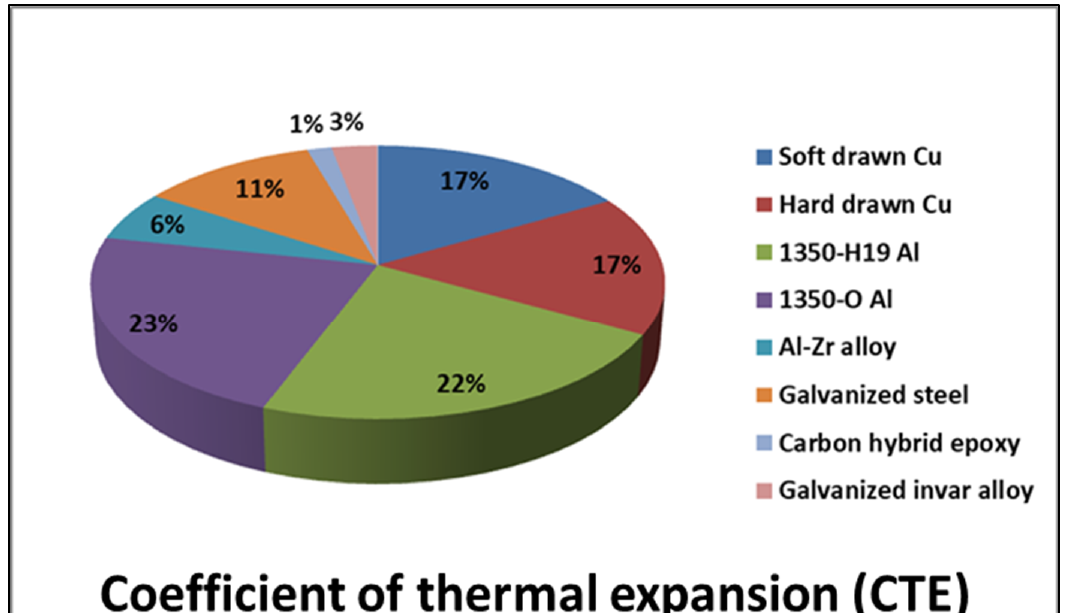
Figure 4. Ampacity versus operating temperature of transmission conductors [39].